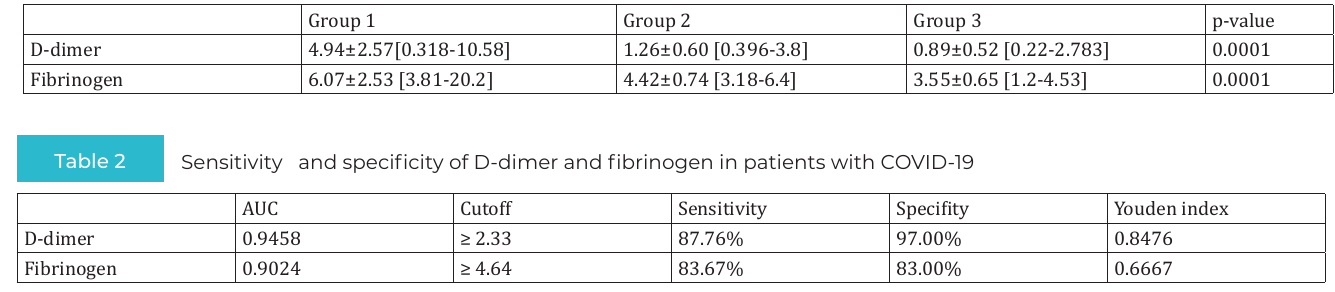
Level of D-dimer and fibrinogen in groups of examined patients